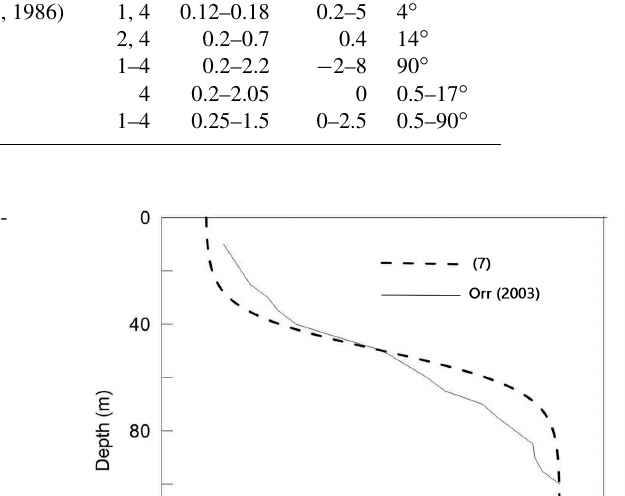
Table 1. Parameters α , β , and γ of ISWs from numerical experiments, laboratory experiments, and field observations. Location Zone α β γ Celtic Sea (Vlasenko et al., 2014) 3 0.8–3.3 1.4 3 ◦ Bay of Biscay (New and Pingree, 1990) 1, 3 1–2 0.8–1.5 4.5 ◦ Andaman Sea (Osborn et al., 1980) 1 0.16 1 0.33–1.5 ◦ Oregon Shelf (Moum et al., 2003) 1 0.85 South China Sea (Orr and Mignerey, 2003) 1 0.8, 1.55 1.1 1 ◦ South China Sea, Dongsha Atoll (Fu et al., 2016) 1.25 Huntington Beach (Nam and Send, 2011) Sea of Japan (Navrotsky et al., 2004) 2 0.5 1 0.1 ◦ St. Lawrence Estuary (Bourgault et al., 2007) 4 1 0 3 ◦ Laboratory experiments (Helfrich and Melville, 1986) 1, 4 0.12–0.18 0.2–5 4 ◦ Laboratory experiments (Chen, 2007) 2, 4 0.4 Numerical experiments (Talipova et al., 2013)